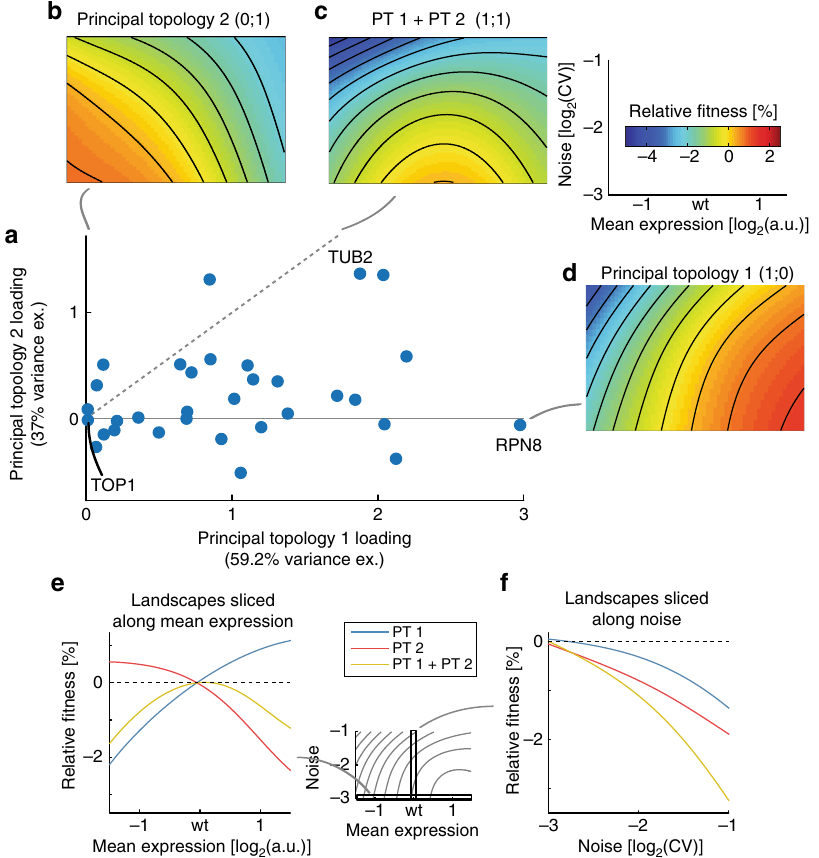
Fig. 5 Two principal topologies of expression- fi tness landscapes. a Principal component analysis of expression- fi tness landscapes reveals two principal topologies (PT) that explain the majority of variation observed across all landscapes. Scatter plot shows PT loadings of individual landscapes (dashed lines show equivalent loadings with both PTs). Note that results for RAP1 are not shown and are discussed in the Supplementary Note 1. Source data are provided as a Source Data fi le. b – d Landscapes show individual principal landscape topologies (PT1 and PT2) and their equivalent combination (PT1 + PT2). These plots show relative fi tness, that is fi tness normalized to fi tness at wild-type mean expression and low noise (log 2 (CV) = − 3). Note that relative fi tness on principal topologies is an arbitrary scale on its own and only becomes meaningful once multiplied by the respective topology loadings of genes. e Principal topologies sliced along mean expression range at minimal expression noise (log 2 (CV) = − 3). f Principal topologies sliced along noise range